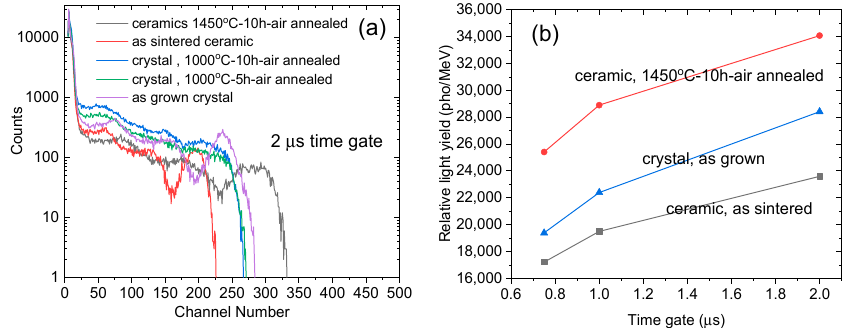
Figure 8. ( a ) Pulse height spectra of the as grown Ce, Pr:LuAG crystals and ceramics, γ -ray 137 Cs, 0.75, 1, 2 µ s time gate, respectively. ( b ) Comparison of relative LY values of Ce, Pr:LuAG crystals and ceramics at different shaping times, 0.75, 1, 2 μ s, respctively.